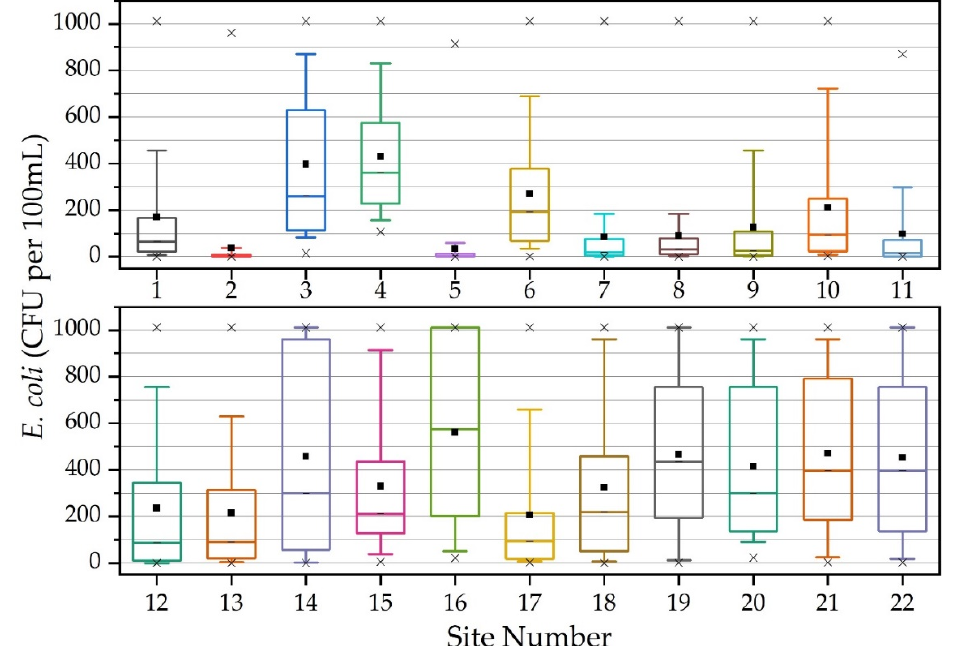
Figure 3. Box and whisker plot of E. coli concentration (CFU per 100 mL) descriptive statistics at 22 sampling locations during study period (2 January 2018–1 January 2019) in West Run Watershed, Morgantown, WV, USA. Box delineates 25th and 75th percentiles; line denotes median; square shows mean; whisker describes 10th and 90th percentiles; x shows maximum and minimum when above and below, respectively.